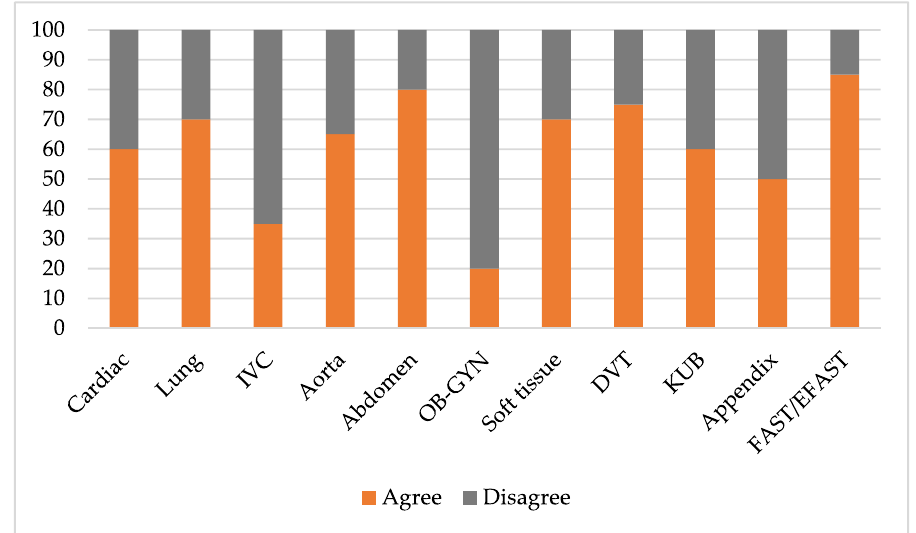
Figure 2. Rating scale of “Agree” and “Disagree” in the image interpretation skill divided by area of POCUS examination. Abbreviations: inferior vena cava (IVC), obstetrics and gynecology (OB-GYN), deep venous thrombosis (DVT), kidney and urinary bladder (KUB), and focused assessment with sonography for trauma (FAST) scan/extended FAST